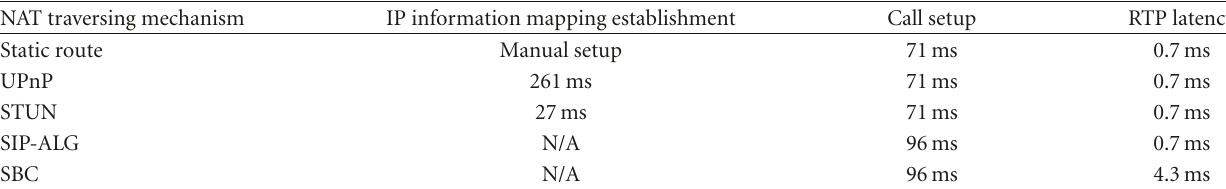
Figure 4: STUN message flow for establishing IP information mapping. Table 1: Time complexities of the NAT traversing mechanisms for